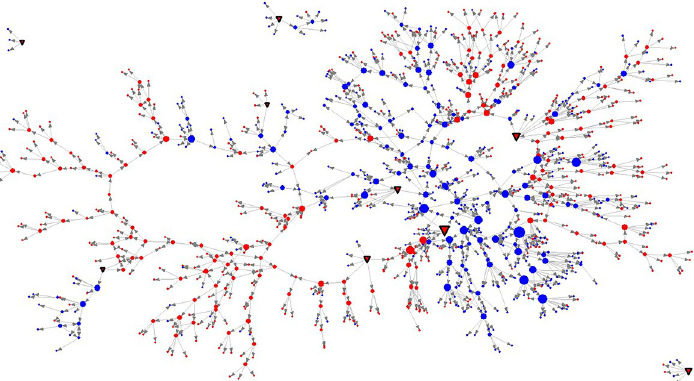
Fig 3. Hairball visualization of the link-tracing network. Node colors indicate three classes of nodes: red down- triangles –seeds (individuals living in Castello´n, Spain), red –people interviewed in Castello´n, Spain, blue– people interviewed in Daˆmbovi ț a, Romania. The network is directed indicating the chain-referral structure of the relational data. Directed dyads are indicative of referees (the origin of the arrow) and referrals (indicated by the arrow head). Size nodes are proportional to their out-degree (the number of referrals provided). By dotted perimeters are indicated components (disconnected parts of the network). The plot was built using the UCINET